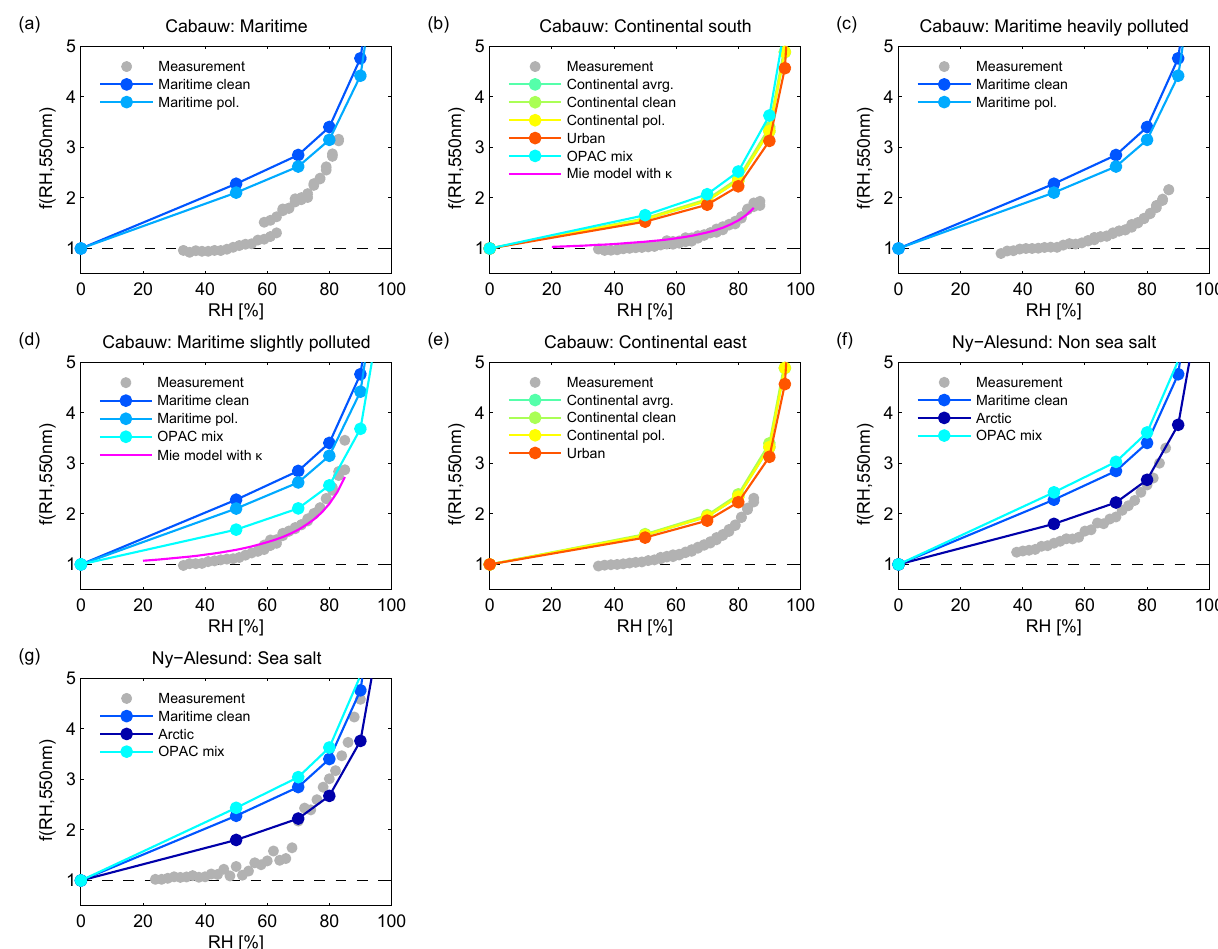
Fig. 8. Example humidograms from the investigated sites (gray bullets) compared to OPAC aerosol examples given in Hess et al. (1998) (colored bullet lines). The cyan bullets (OPAC mix) denote the OPAC result if the individual OPAC components are weighted with the measured size distribution. The magenta line shows the calculated humidogram using the measured size distribution, the (partially) measured chemical composition, the hygroscopicity parameter κ , and Mie calculations if the measurements were available (see text for details).